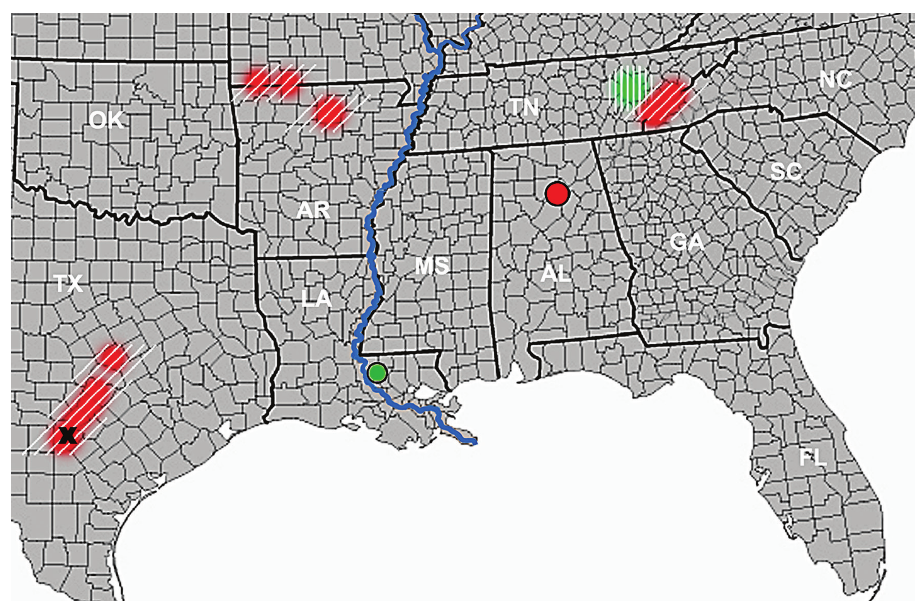
Figure 5. Map of the South of eastern United States, showing positions of locality records for the newly described species of Anillinus and the ranges of their presumed relatives (localities of the same color re- flect supposed relatedness). A. felicianus , green circle; A. relictus , red circle. Green area with vertical line pattern – range of A. sinuaticollis . Black cross – type locality of A. sinuatus . Red areas with diagonal line pattern – ranges of the species of Anillinus whose males have a spine-like structure in the endophallus of the median lobe (after Sokolov et al. 2004; Sokolov and Watrous 2008; Sokolov 2011; Sokolov et al. 2014; Sokolov et al. 2017). Blue line – Mississippi River. State abbreviations follow Federal Infor- mation Processing Standards (https://www.nlsinfo.org/content/cohorts/nlsy79/other-documentation/